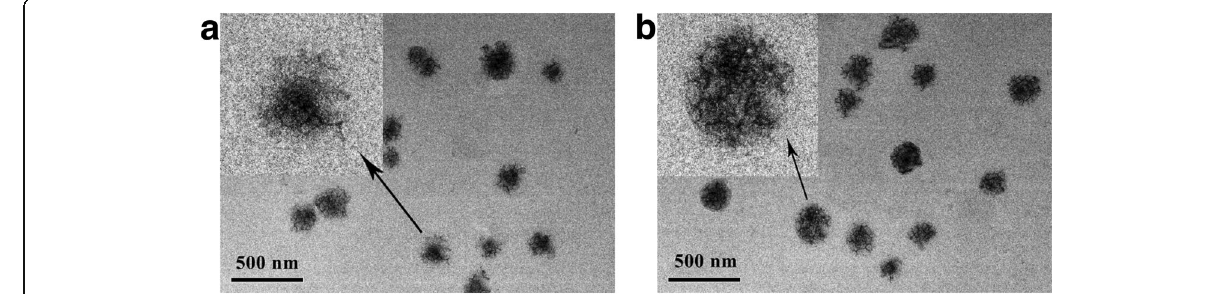
Fig. 1 a TEM image of liposome; and b ) the hirudin/liposome